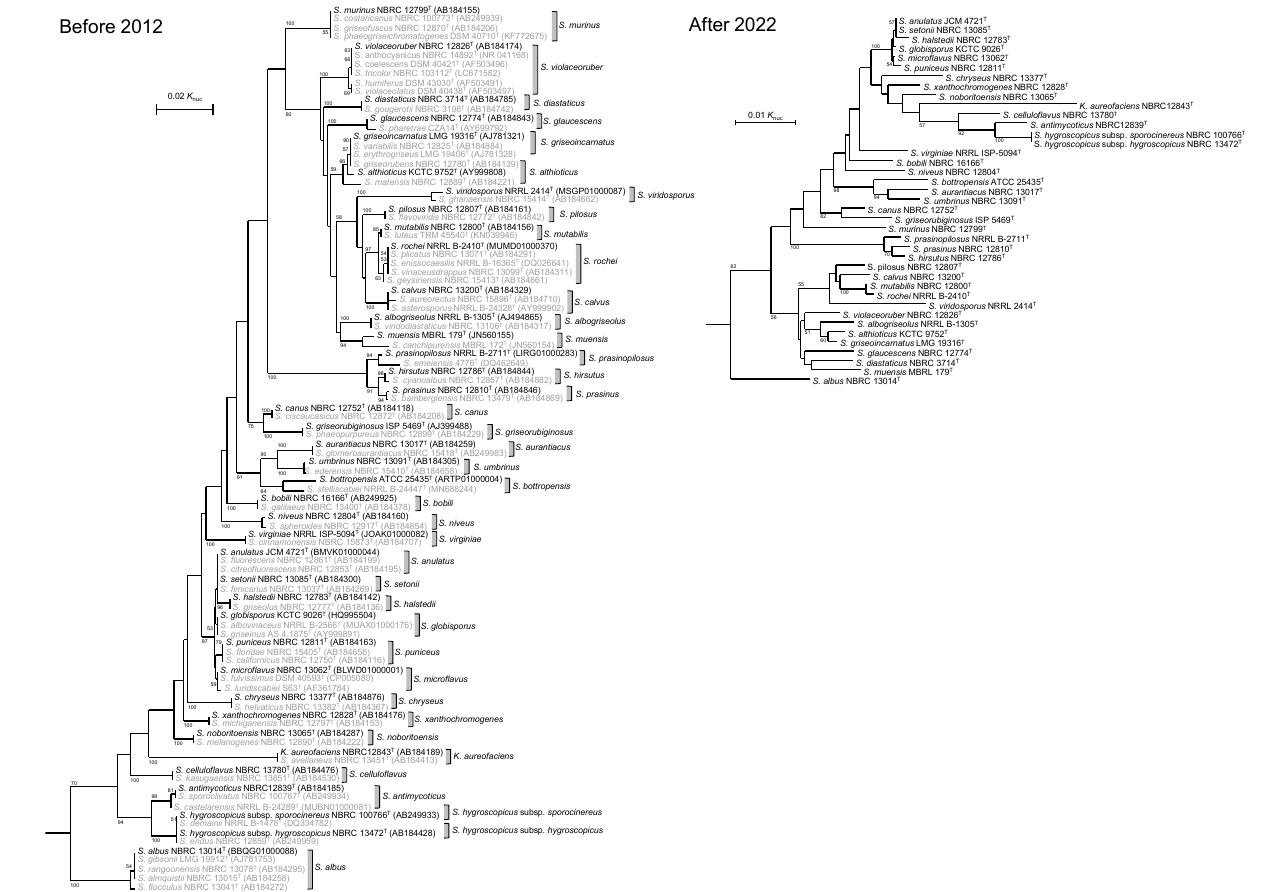
Figure 5. Phylogenetic trees of the type strains of species or subspecies listed in Table 3. Left panel (before 2012): type strains of later heterotypic synonyms are shown in gray. Scienti fi c names with priority (correct names) are in black. Right panel (after 2022): strains identi fi ed as later heterotypic synonyms were removed. The tree was reconstructed by the NJ method. Numbers on branches indicate the percentage bootstrap values of 1000 replicates; only values >50% are indicated. Nocardia terpenica IFM 0706 T (JABMCZ010000003) is used for an outgroup (not shown) to indicate the root of this